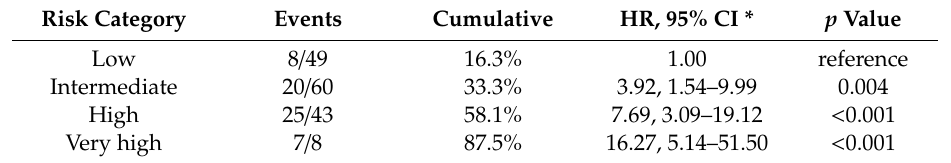
Table 3. Cumulative probability of death and multivariate adjusted hazard ratios by risk category. Risk